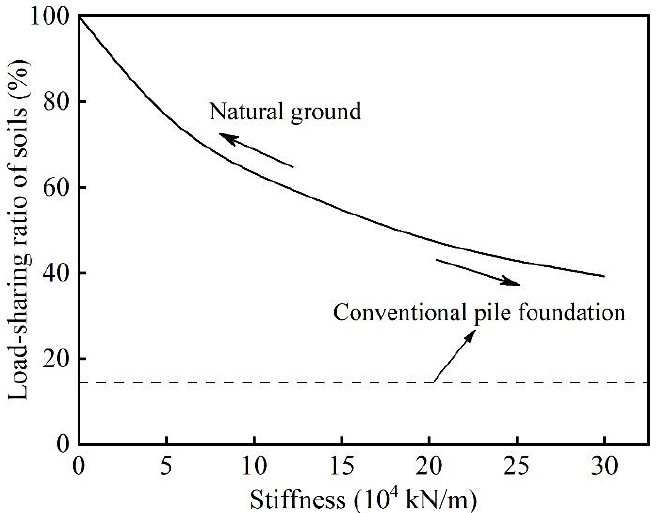
Figure 15. Curve of load-sharing ratio of soils variation with stiffness of deformation adjustors .